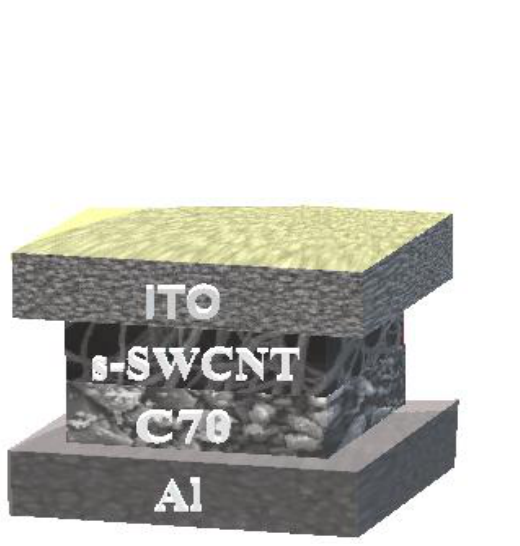
Figure 2. 3D schematic view of the proposed and simulated PHJ structure.